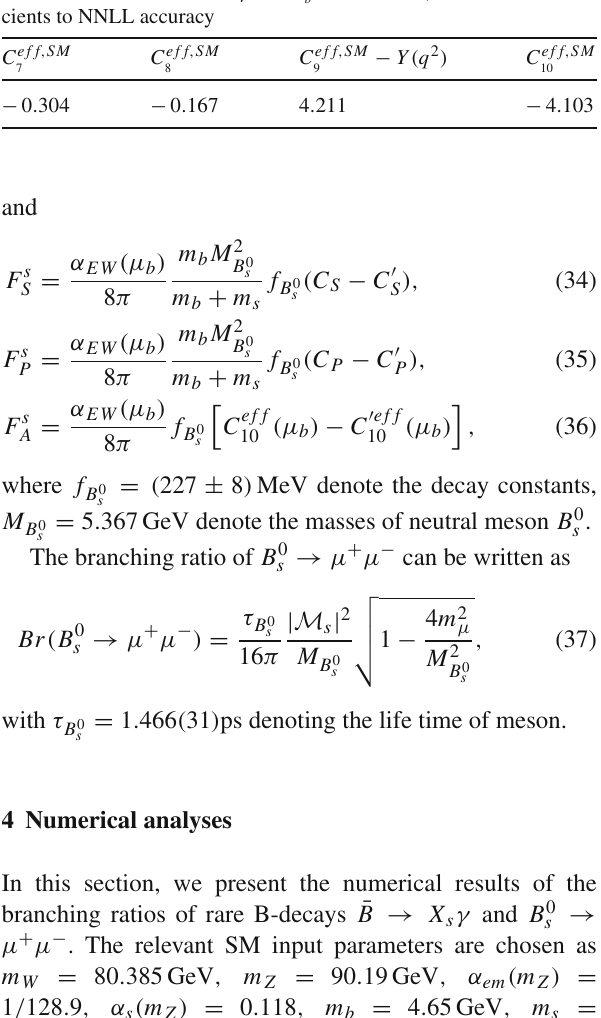
(cid:11) 4 . 65GeV, SM Wilson coeffi- b